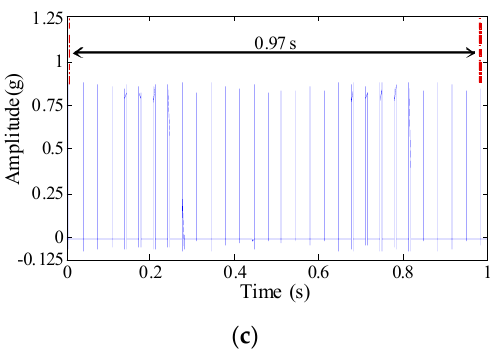
Figure 19. The analytic results of planetary bearing outer ring fault. ( a ) The time domain waveform of planetary bearing outer ring fault; ( b ) The envelope spectrum of planetary bearing outer ring fault; ( c ) The key phase signal of sun gear input shaft.